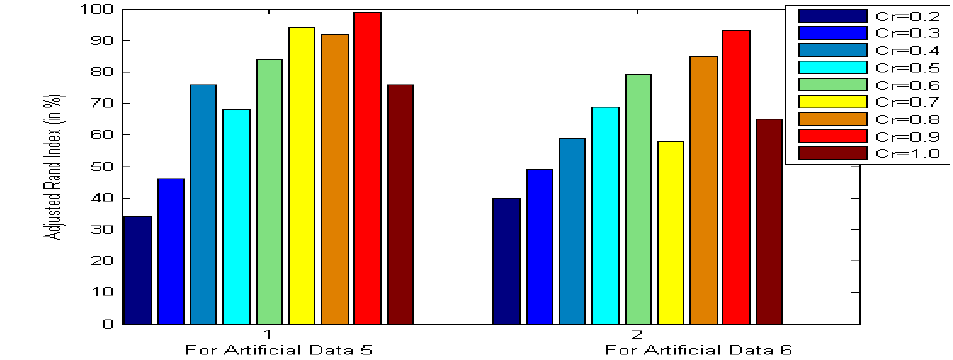
Figure 3. Final clustering result for artificial datasets 5 and 6 with MODE for different settings of crossover rate Cr